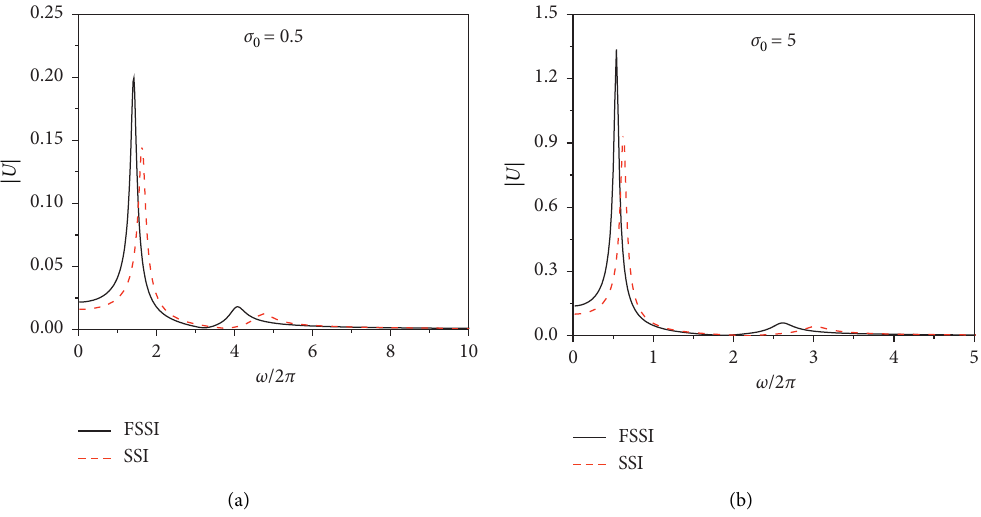
Figure 24: The displacement amplitude of the cylinder on the top with respect to ω with c